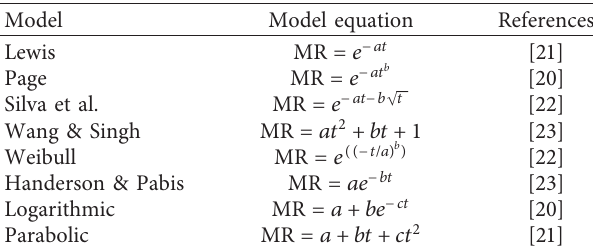
Table 1: Mathematical models.